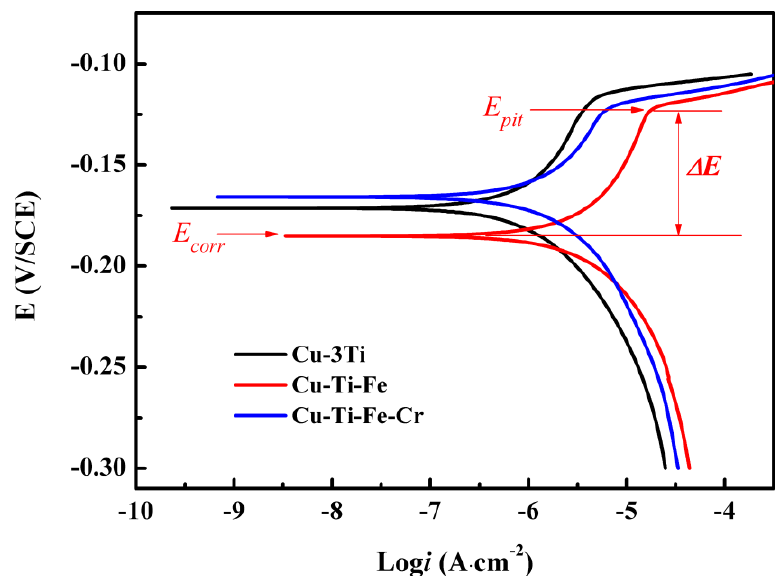
Figure 6. Polarization curves of the three alloys, aging at 450 ◦ C, for the peak-aging time, in 3.5 wt. % NaCl solution.